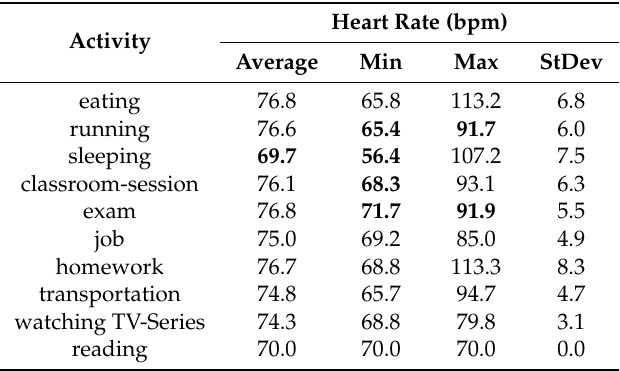
Table 6. Heart Rate by